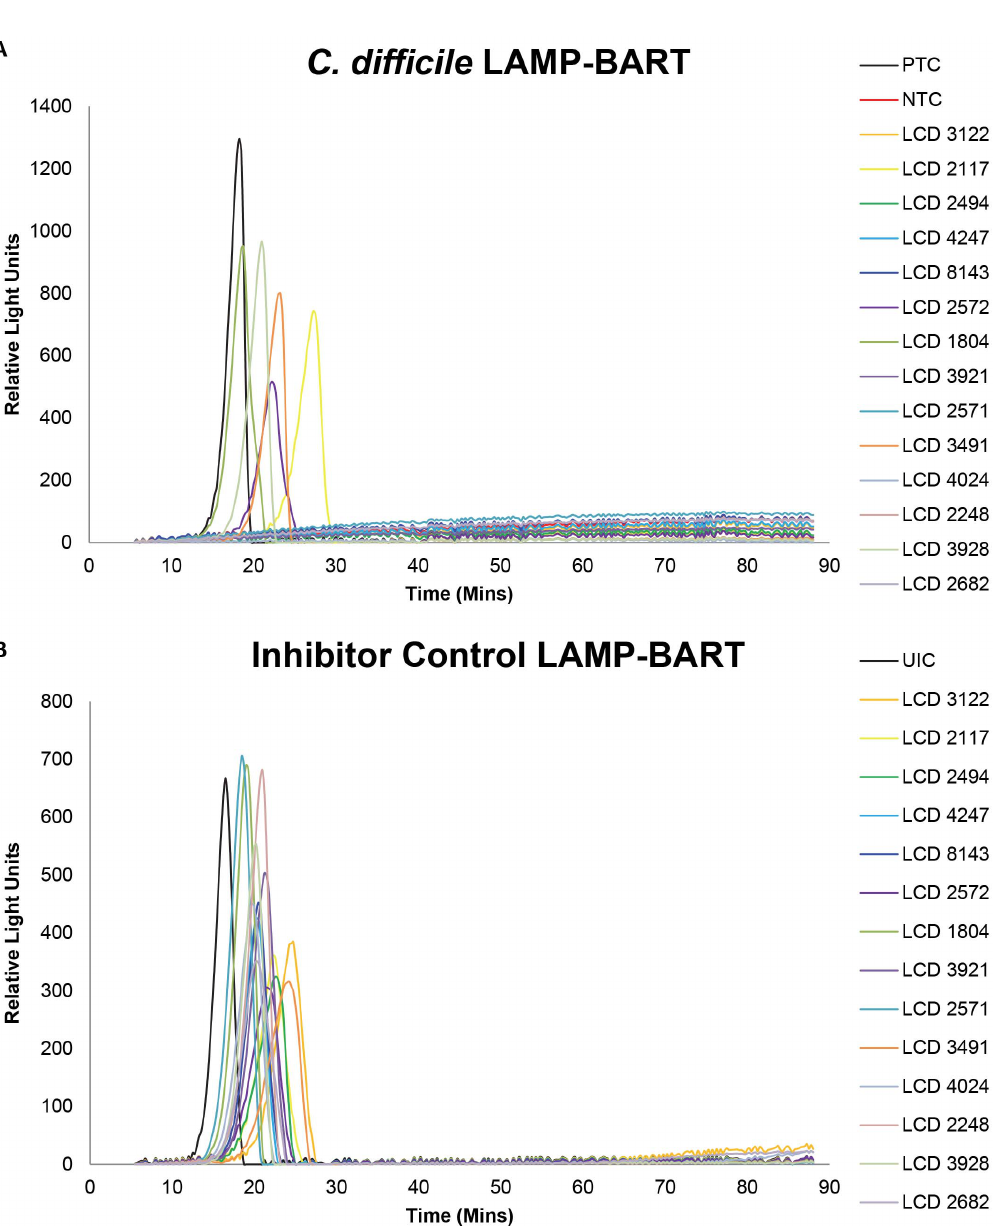
Figure 2. Example C.difficile HE-LAMP-BART results. One HE-LAMP-BART run of 14 samples from the Illumigene comparison. Panel A shows the C. difficile LAMP-BART peaks obtained and includes a positive control of 10 4 copies of C. difficile genomic DNA (PTC) and a no template control (NTC). Panel B shows the Inhibitor Control LAMP-BART results obtained simultaneously from the same set of HE eluates and a buffer uninhibited control